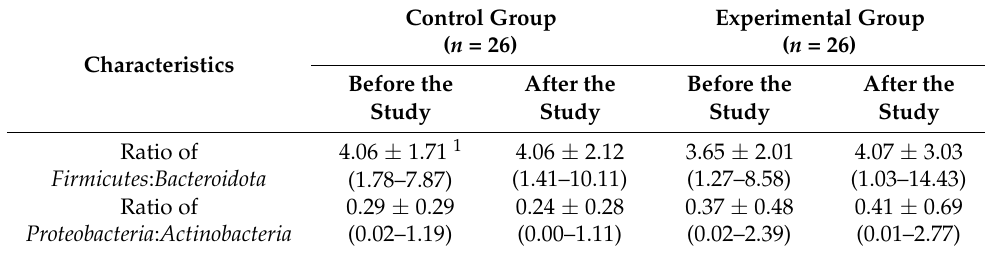
Figure 2. Comparison of the shift in alpha diversity ( A ) and beta diversity ( B ) between the start and end of the study. n.s.: not significant. Table 3. Characteristics of the gut microbiome ( n =